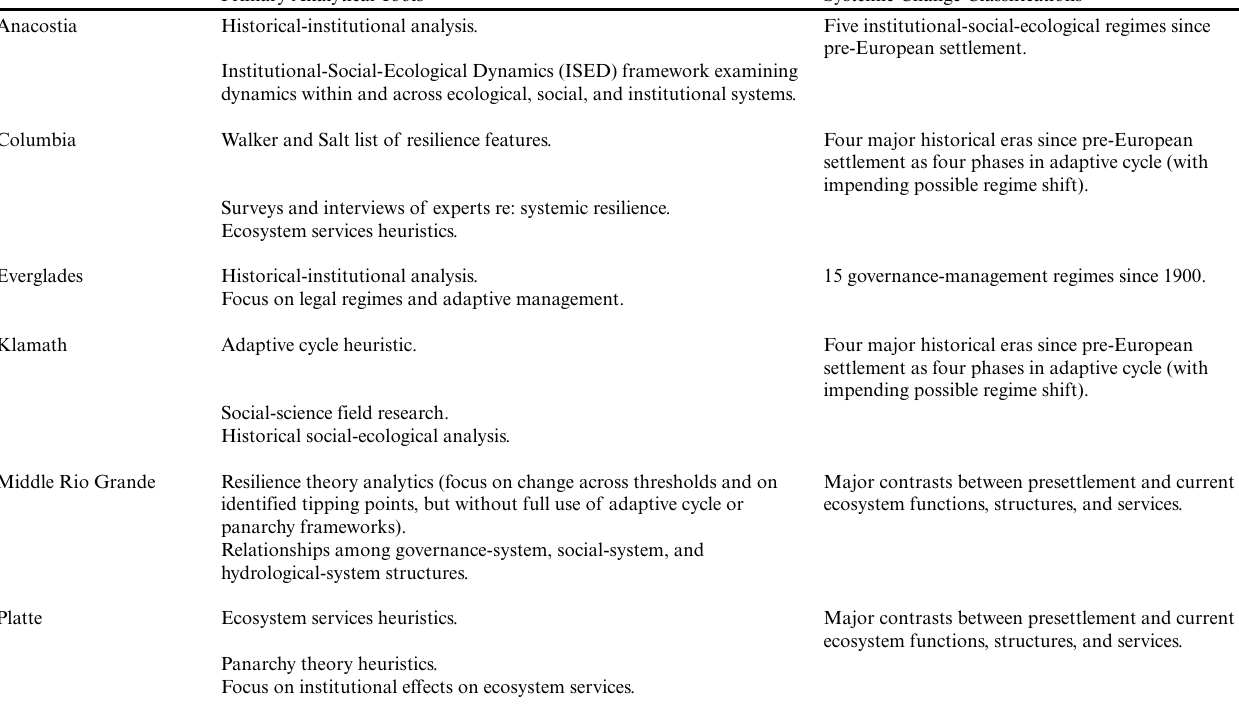
Table 2 . Comparisons of basin